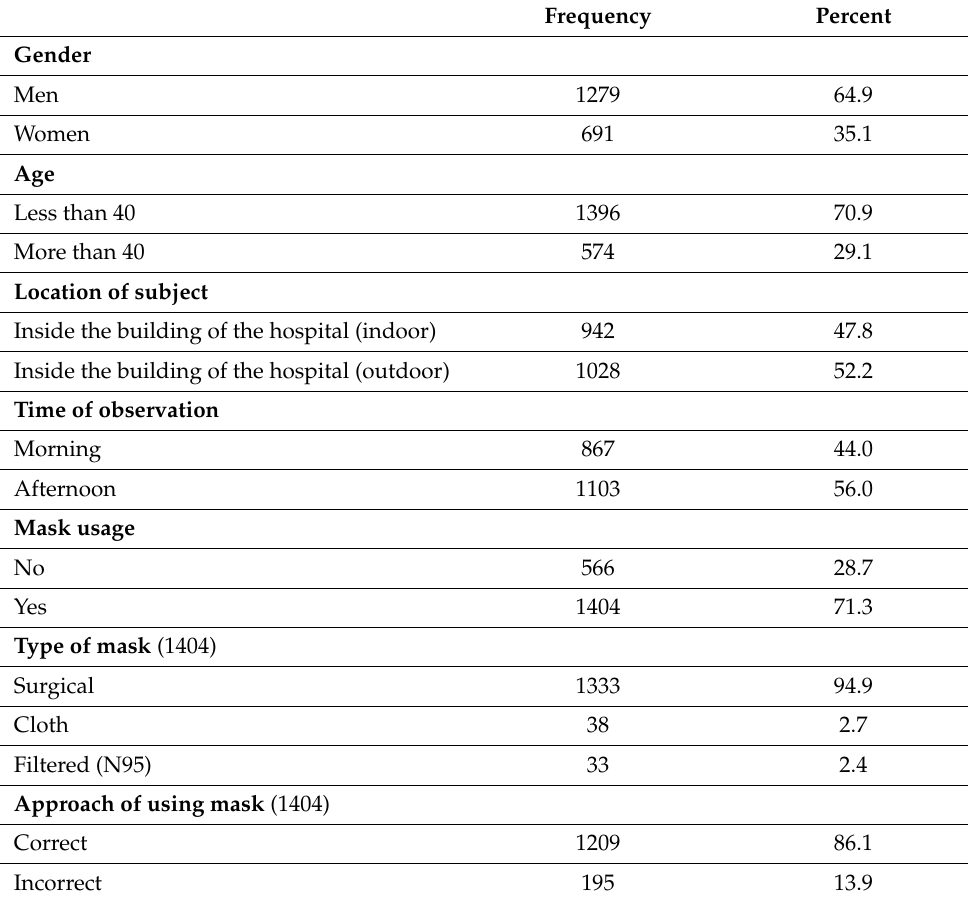
Table 1. Characteristics of